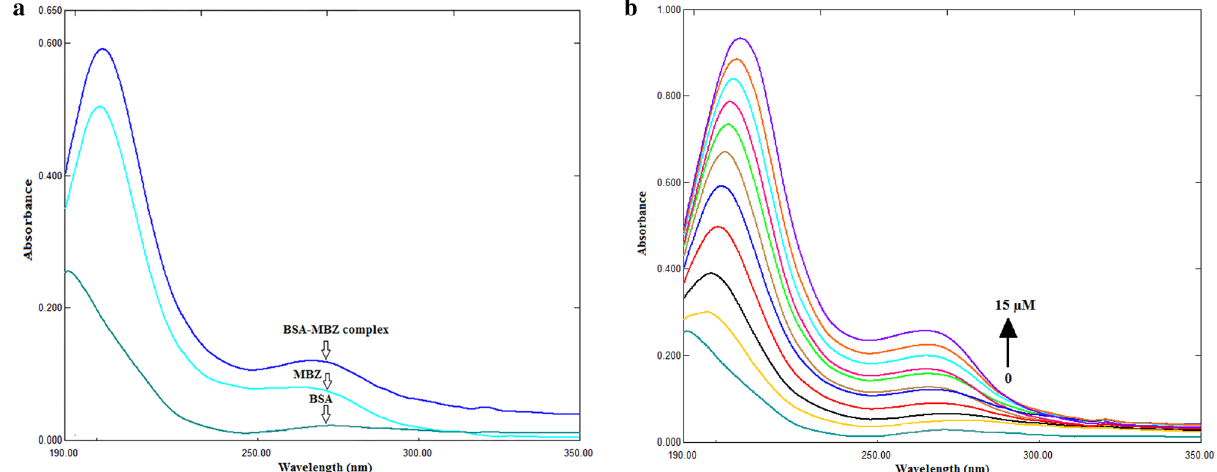
Figure 2. ( a ) UV–visible absorption spectra of MBZ (5 µM), BSA (40 µM), and BSA-MBZ complex at 298 K and pH 7.4. ( b ) UV–visible absorption spectra of BSA (C BSA = 40 µM) and MBZ C MBZ = (1, 2, 4, 5, 6, 8, 9, 10, 12, 15 µM) at 298 K and pH